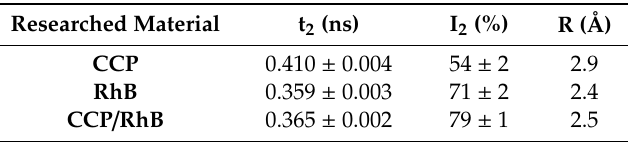
Table 6. Positron lifetime t 2 , their relative intensity I 2 (at vacuum), and the estimated radius of micropores for CCP, rhodamine (RhB), and their composite.